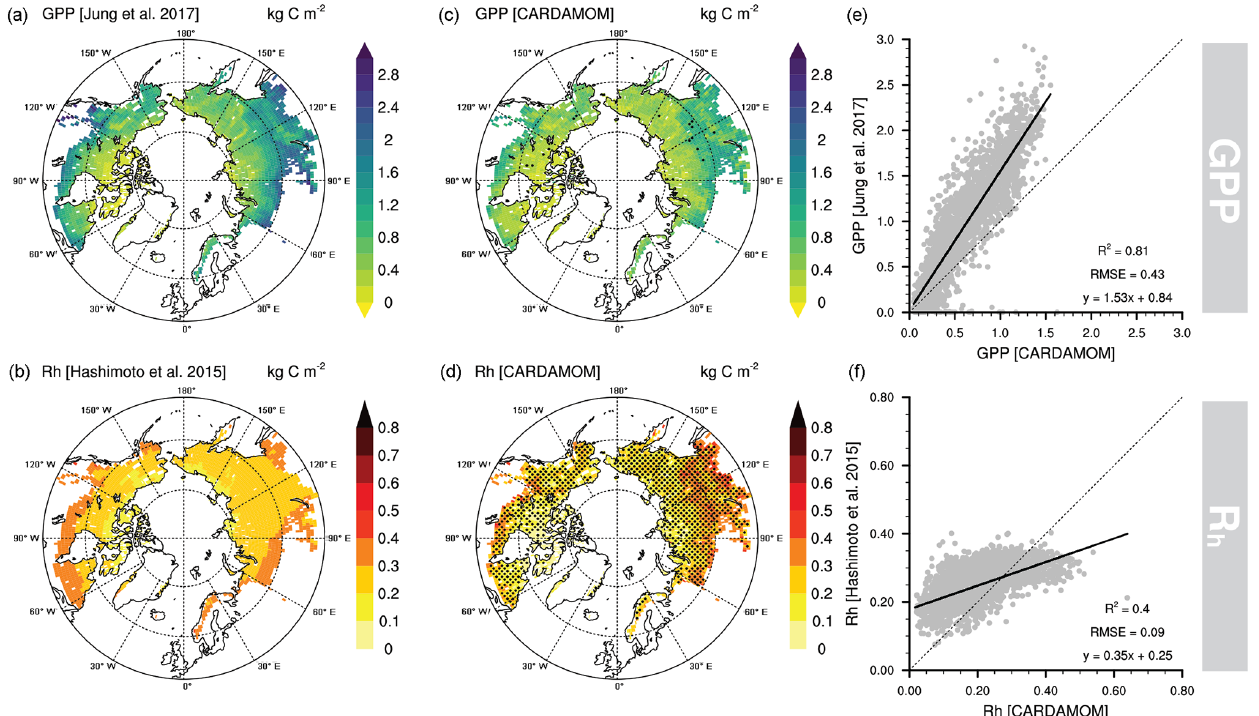
Figure 3. Original gross primary productivity (GPP; Jung et al., 2017) and heterotrophic respiration ( R h ; Hashimoto et al., 2015) datasets used in the data validation process (a, b) , estimated GPP and R h by CARDAMOM (c, d) , and their respective goodness-of-fit statistics between original and assimilated datasets (e, f) . Stippling indicates locations where the independent datasets are within CARDAMOM’s 5th and 95th